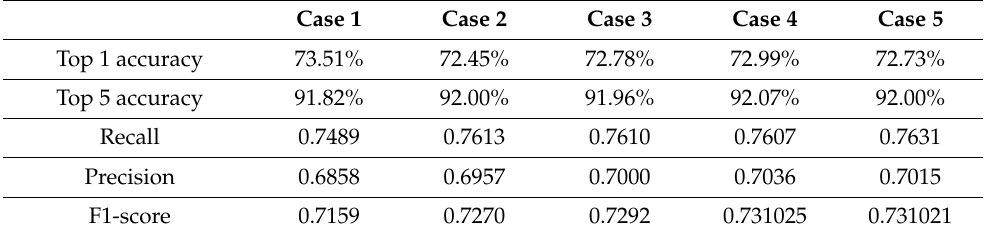
Table 4. Comparison of classification accuracy by case with validation data.